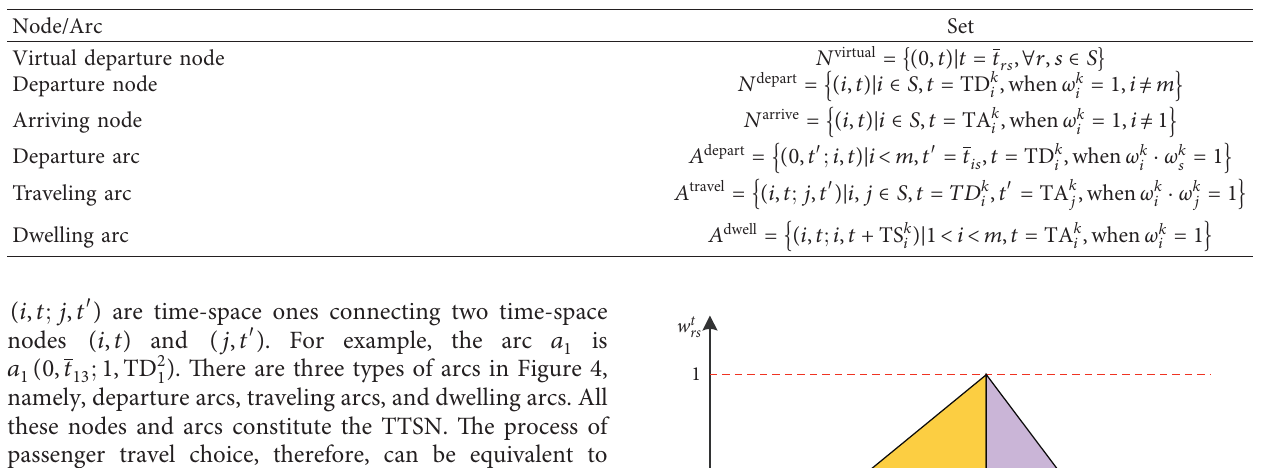
Table 1: Set of nodes and arcs in TTSN.